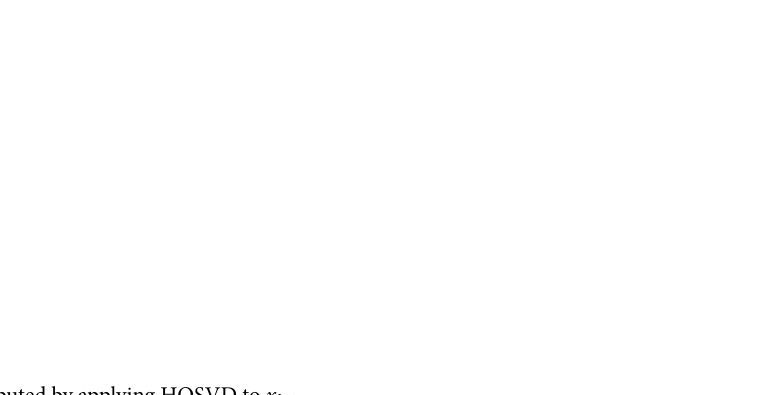
Table 4. G (ℓ 1 , 2, 2 ) computed by applying HOSVD to x ktj